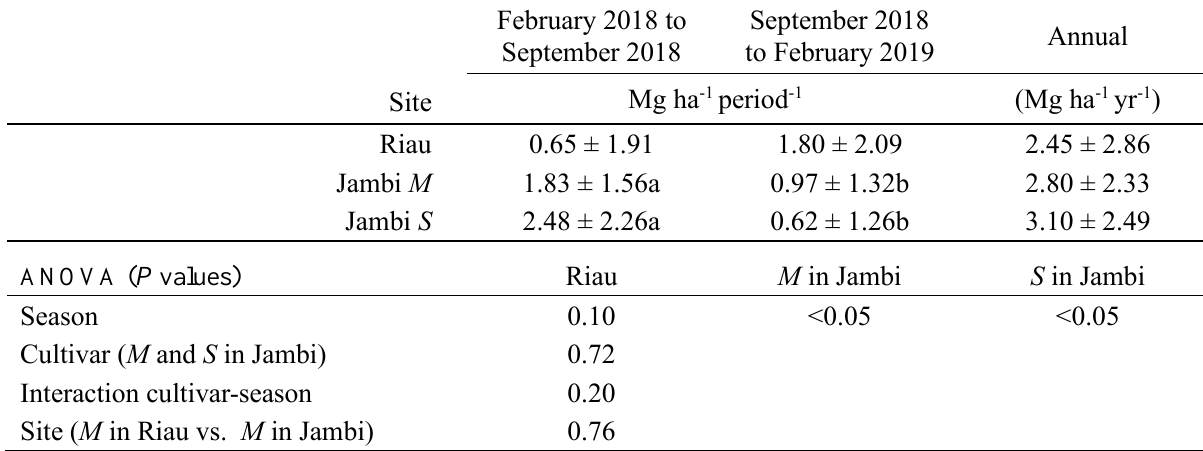
Table 6. Results of Tukey HSD test ( P < 0.05) and ANOVA for fine root production (NPP as C) in Riau and Jambi (mean ± 1 SD; n = 12 for Feb–Sep 2018 in Riau, 36 for Sep 2018 to Feb 2019 in Riau, 24 for M in Jambi, and 12 for S in Jambi). Suffixed lowercase letters indicate significant differences in seasonal production.